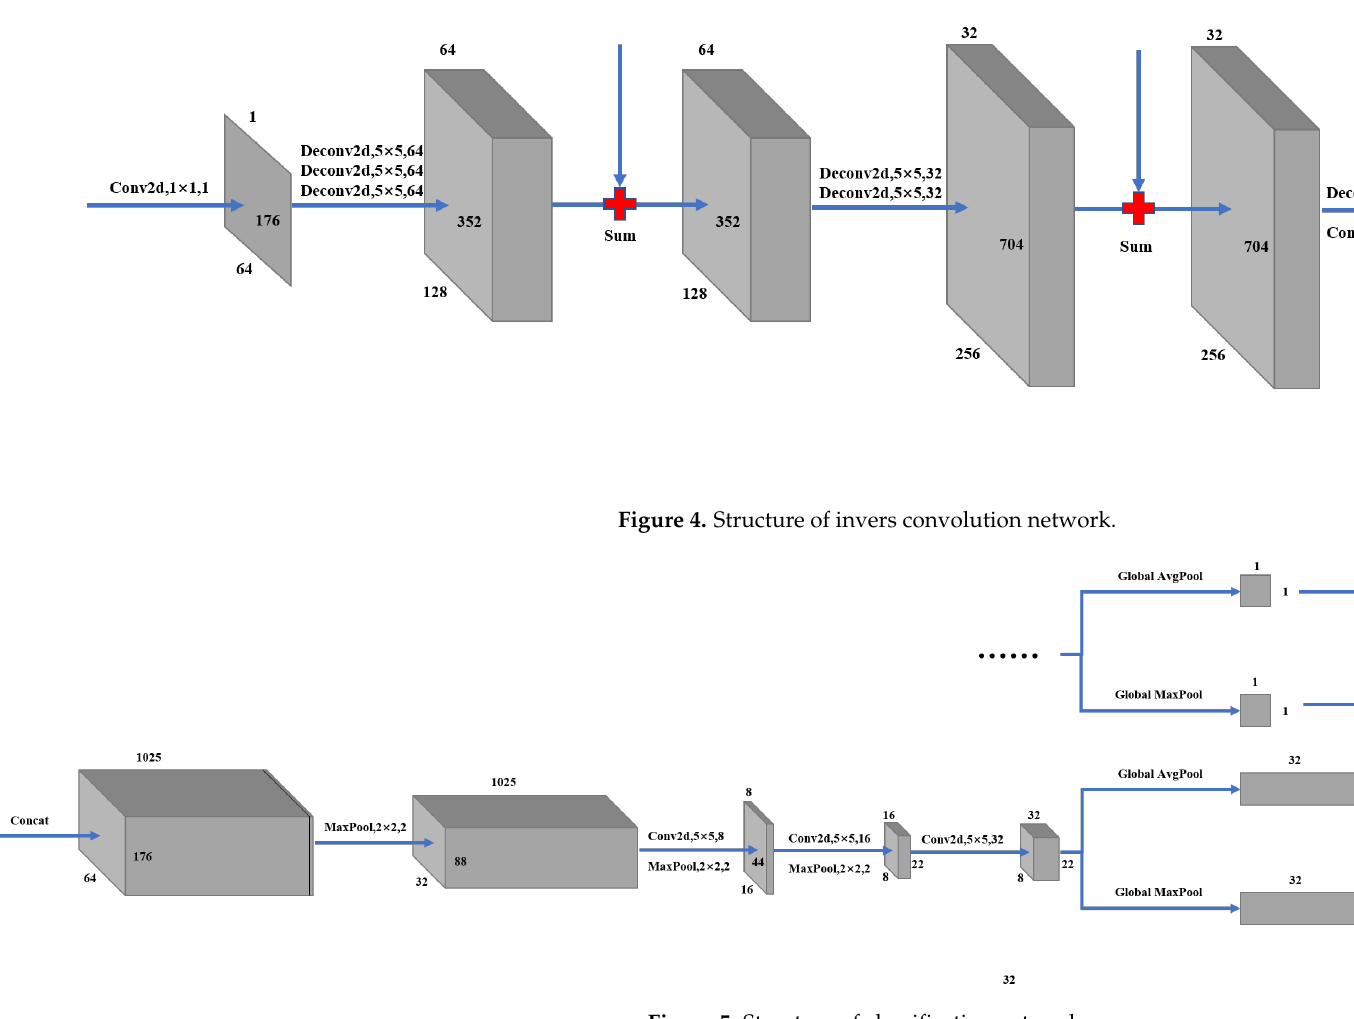
Figure 5. Structure of classification